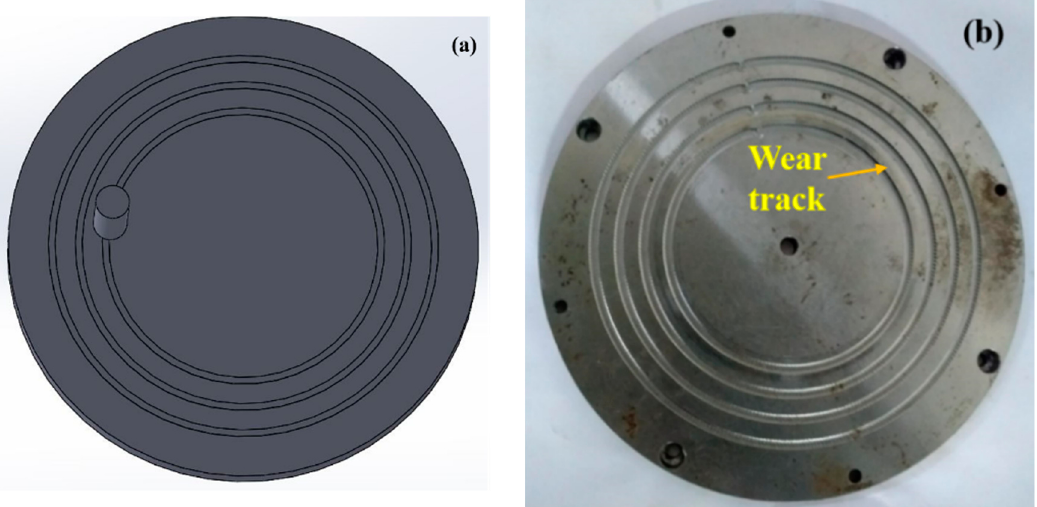
Figure 3. ( a ) Schematic arrangement of the pin on the circular-groove-textured disc, and ( b ) wear track obtained during experimentation.